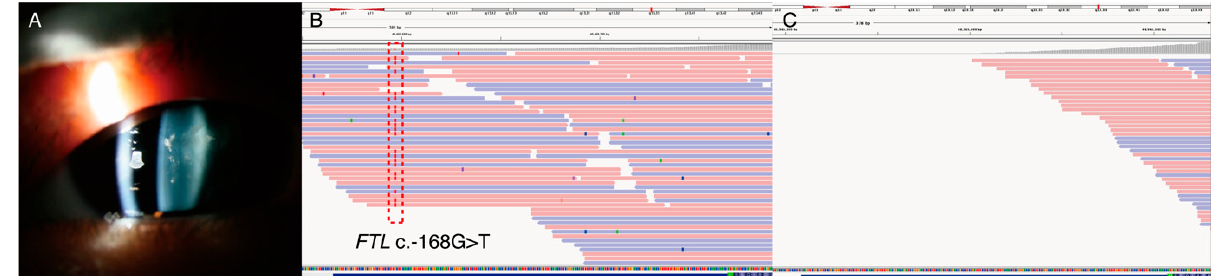
Figure 4. (P38) A 7-year-old male had congenital cataracts in both eyes. Laboratory examination showed elevated ferritin level 1205.3 ng/mL (reference range: 23.9~336.2 ng/mL) without iron overload. The inheritance pattern was consistent with autosomal dominant. ( A ) Slit-lamp examination showed congenital cataracts since early childhood. ( B ) Integrative genomic viewer showed FTL c.-168G>T variant in upstream to starting codon. This region was included in our panel, and the variant was previously reported as pathogenic. ( C ) The 5 ′ untranslated region of exon 1 in FTL gene was not covered in commercially available exome sequencing. Molecular diagnosis of hyperferritinemia-cataract syndrome enables us to avoid unnecessary investigations or treatment such as repeated phlebotomy or liver biopsy.